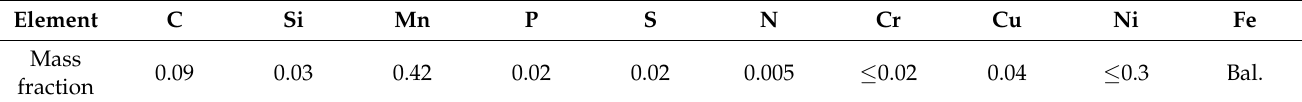
Table 2. Chemical composition of the Portland cement used in this study. Oxides.